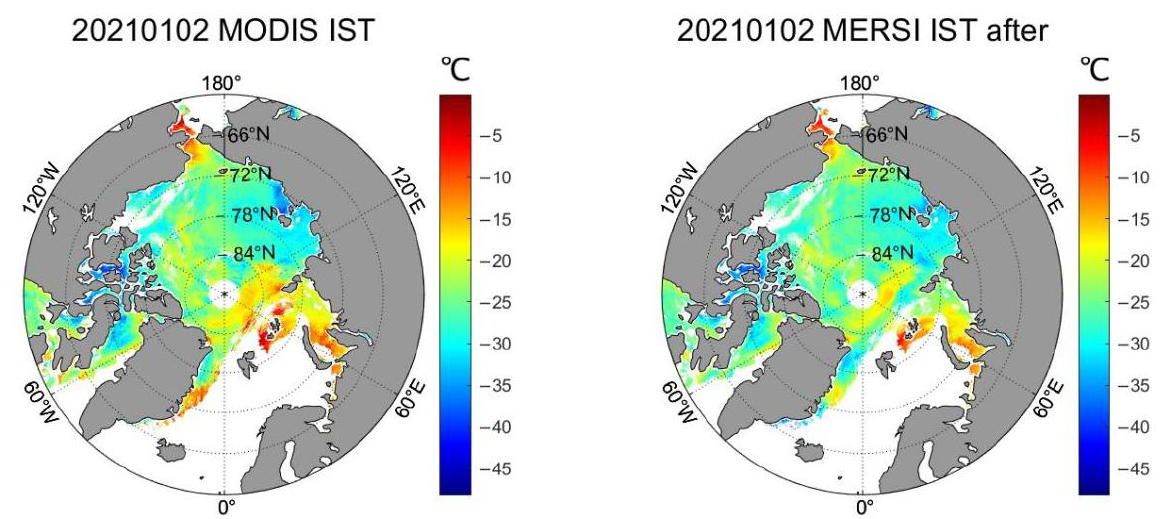
Figure 10. Comparison of distribution maps of the MODIS MYD29 IST product and MERSI inversion daily IST result after calibration on 2 January 2021.